Question: Write a caption explaining this figure to a reader.
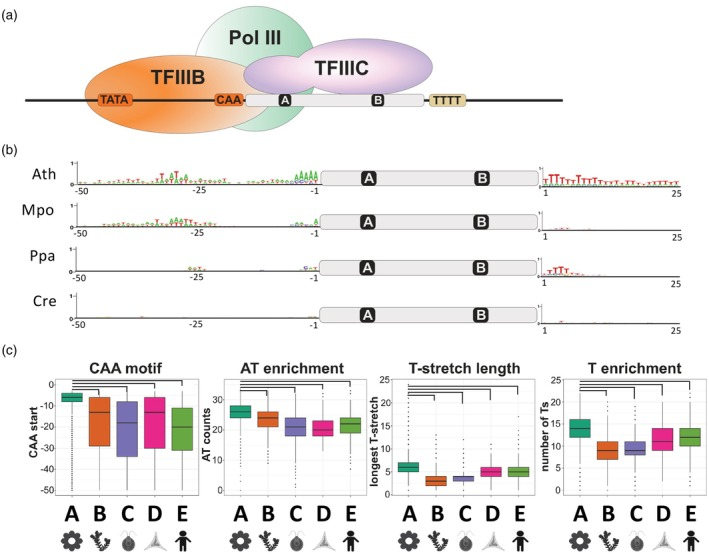
Answer: Comparative analysis of cis ‐regulatory elements associated with tDNA transcription. (a) Schematic representation of the major cis ‐regulatory elements associated with RNA polymerase III (Pol III) transcription of tDNAs. Upstream regions include A/T‐rich sequences and CAA motifs, while internal A and B boxes and downstream poly‐T stretches define the core Pol III promoter architecture. These elements interact with transcription factors TFIIIB and TFIIIC to ensure transcriptional initiation, elongation, and termination. (b) Sequence logos showing nucleotide conservation in upstream (−50 to −1) and downstream (+1 to +25) flanking regions of tDNAs from Arabidopsis thaliana (Ath), Marchantia polymorpha (Mpo), Physcomitrium patens (Ppa), and Chlamydomonas reinhardtii (Cre). The +1 position marks the first nucleotide of the mature tRNA. In (a) and (b), A and B refer to the internal A‐box and B‐box promoter elements, which are located within the tDNA coding sequence and serve as binding sites for the transcription factor TFIIIC. (c) Boxplots comparing cis ‐regulatory sequence features across five major organismal groups: (A) angiosperms ( n = 16 367 tDNAs), (B) non‐angiosperm embryophytes ( n = 8091), (C) other Archaeplastida ( n = 2018), (D) photosynthetic eukaryotes with secondary plastids ( n = 411), and (E) non‐photosynthetic eukaryotes ( n = 1298) (see Figure S2 for details). Parameters include the position of the first upstream CAA motif, upstream A/T content, the length of the longest downstream poly‐T stretch, and downstream T enrichment. Statistical significance relative to angiosperms is indicated by horizontal bars (**** P < 0.0001; see Table S2 ; Figures S2–S6 ).